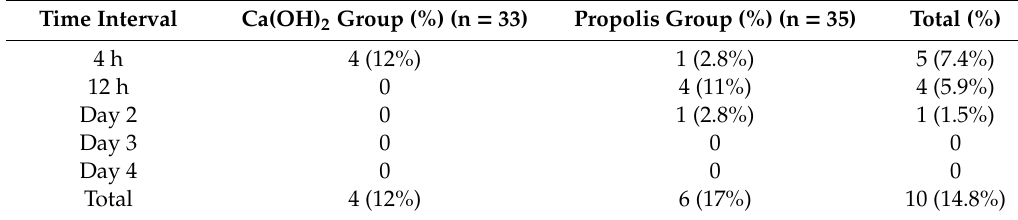
Table 3. Incidence of